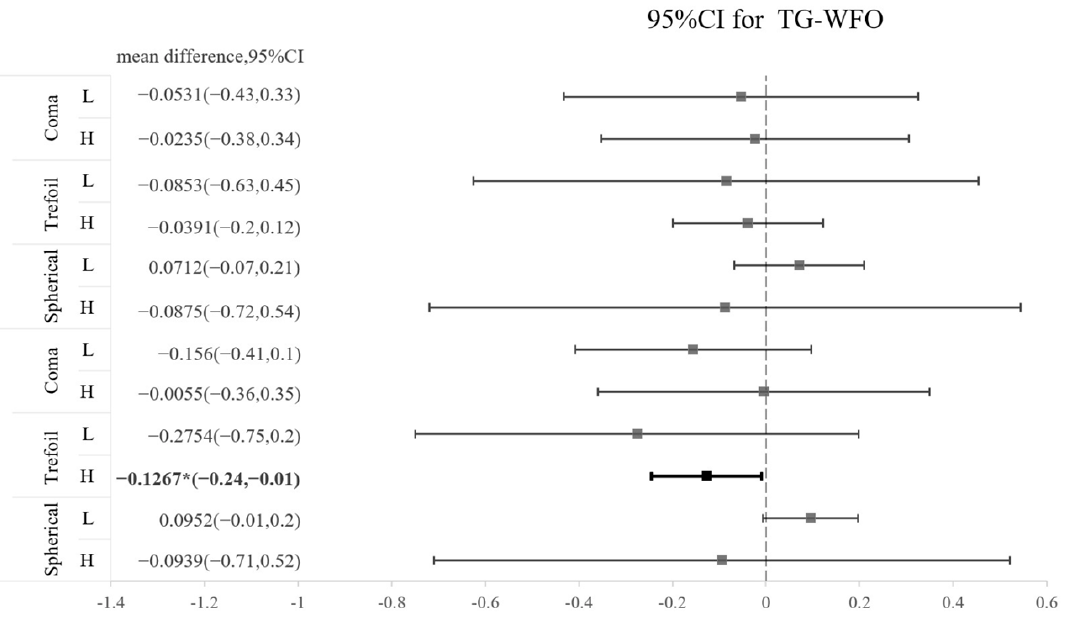
Figure 1. Forest plot of the standardized mean difference in surgically induced HOA or postoperative HOA between TG and WFO on coma, trefoil, and spherical aberration with 95% confidence intervals stratified by level of myopia (L: low; H: high). Table 4. Preoperative and postoperative contrast sensitivity between TG-LASIK groups after 3 months.